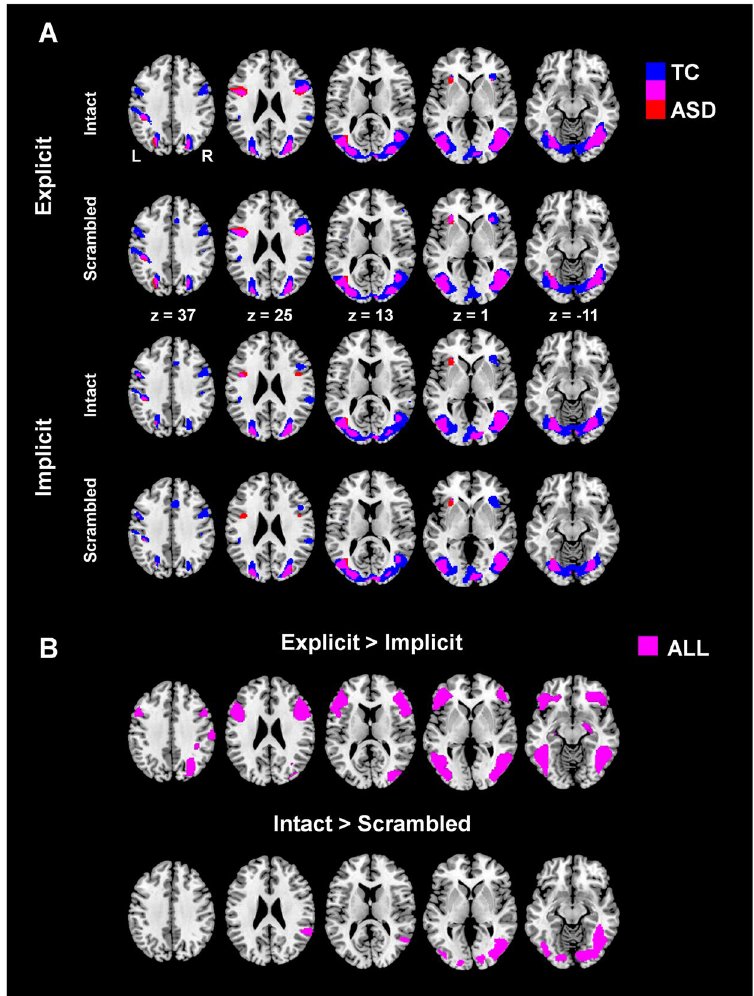
Figure 2. Whole-brain analysis of task-related brain activity during biological motion processing. Panel A visualizes for each group (ASD, TC) task-related brain activity ( > fixation) during explicit and implicit biological motion processing, separately for intact and scrambled PLDs. Panel B visualizes across groups (ASD and TC) differences in task-related brain activity for explicit versus implicit processing (upper panel) and for processing of intact versus scrambled PLD (lower panel). (whole-brain p < 0.05 voxel-wise threshold, FWE-